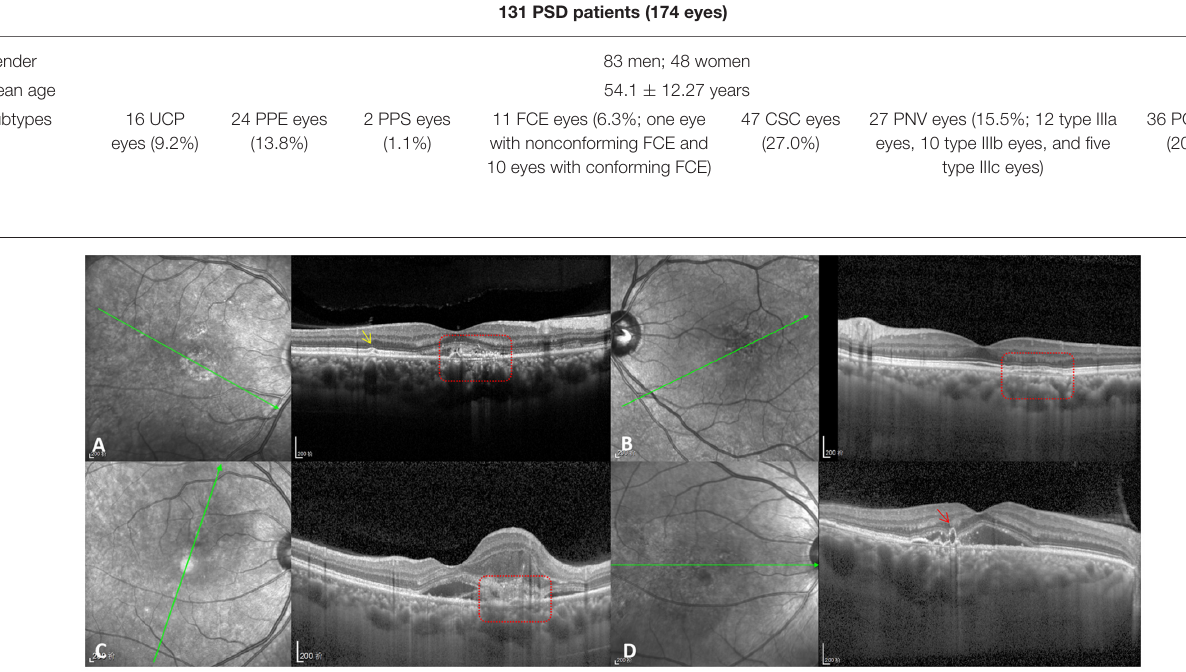
FIGURE 2 | CNV types in PSD patients. (A) Type IIIa PNV (red dotted box) with pachydrusen (yellow arrow). (B) Type IIIb PNV (red dotted box). (C) Type IIIc PNV (red dotted box) with type 2 CNV. (D) Naked polypoidal lesion (red arrow) in a PCV eye.